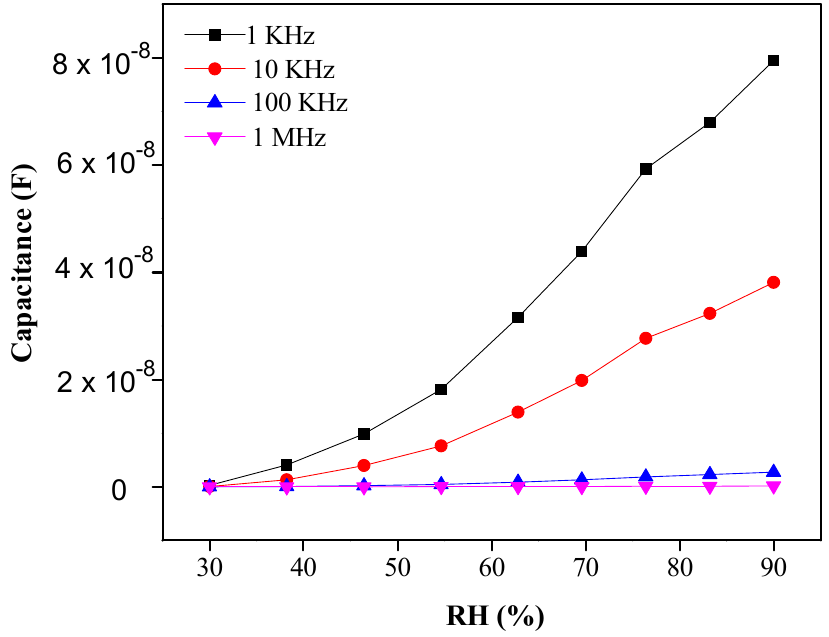
Figure 6. Capacitance response of PEO − CuO − MWCNT: 3% nanocomposite at different % RH.